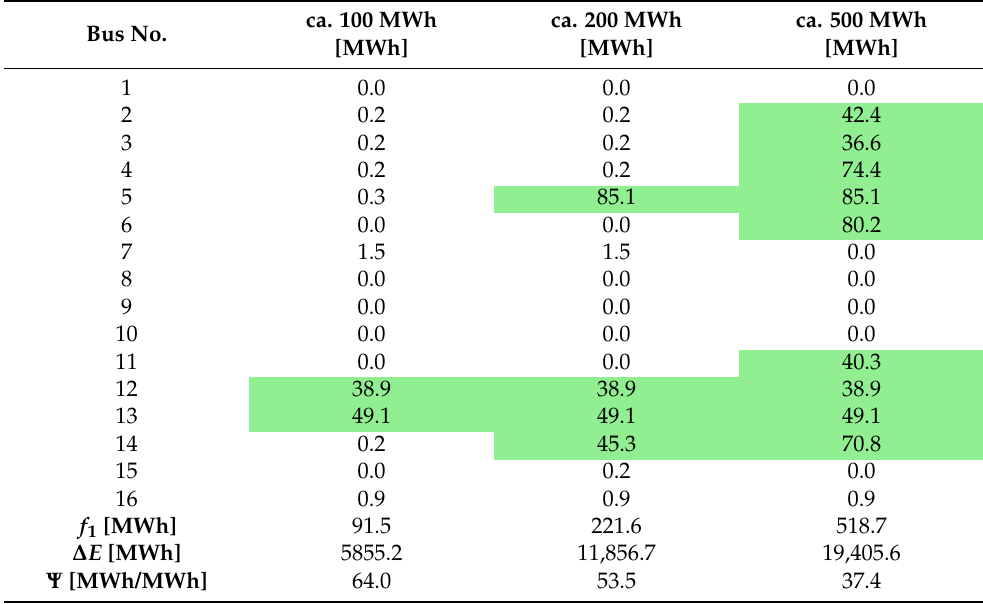
Table 4. Three solutions founded by pa (cid:101) -BRKGA with ca. 100 MWh, 200 MWh and 500 MWh of overall BESS capacity for Test Case 1.